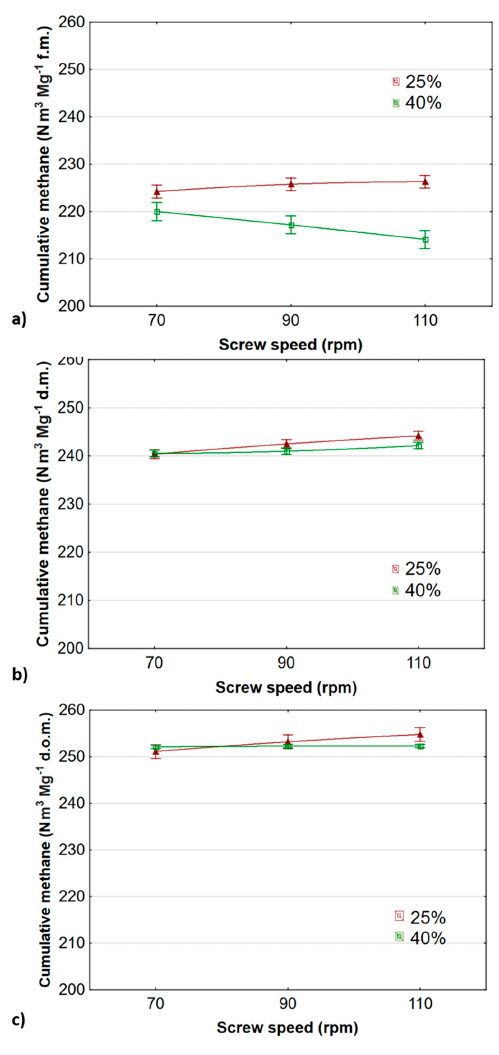
Figure 4. Cumulative methane efficiency from corn straw subjected to extrusion treatment at various screw speed and moisture content: ( a ) cumulative methane for fresh mass, ( b ) cumulative methane for dry matter, ( c ) cumulative methane for dry organic matter.